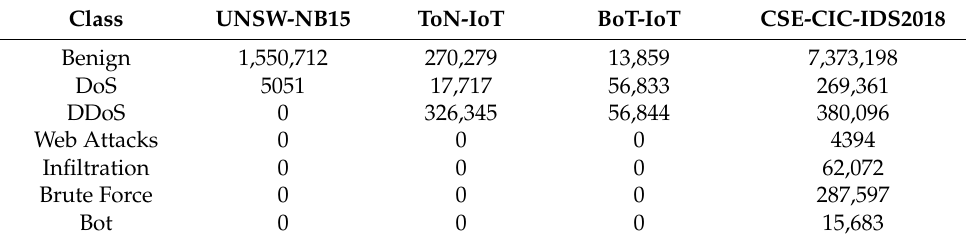
Table 3. Comparison of datasets on coverage of latest attacks